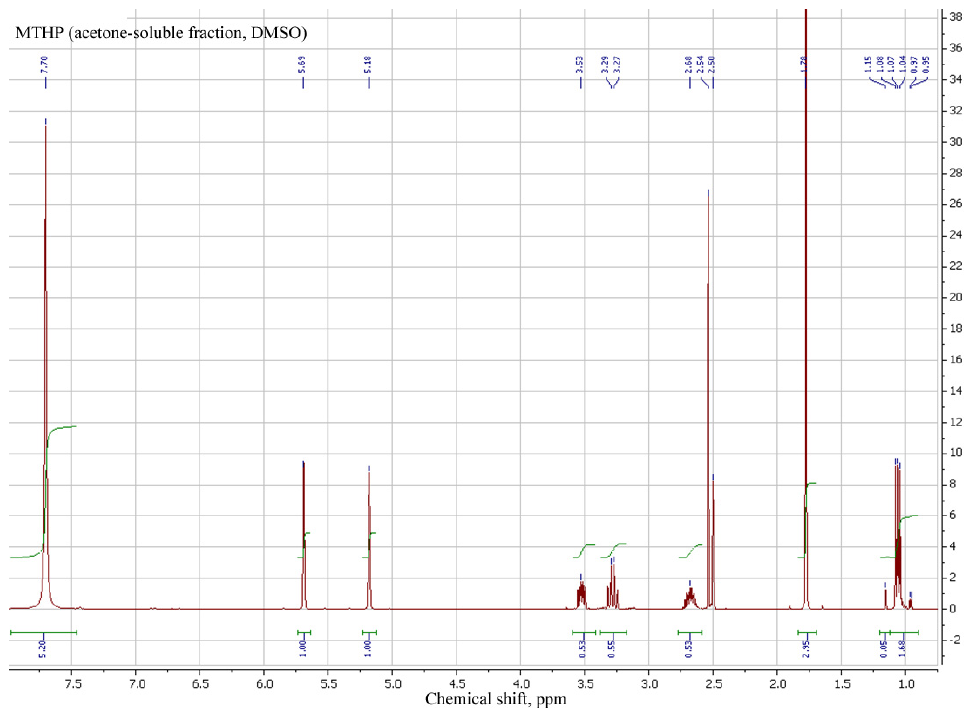
Figure 3. NMR 1 H spectrum of MTHP acetone-soluble fraction in deuterated DMSO.